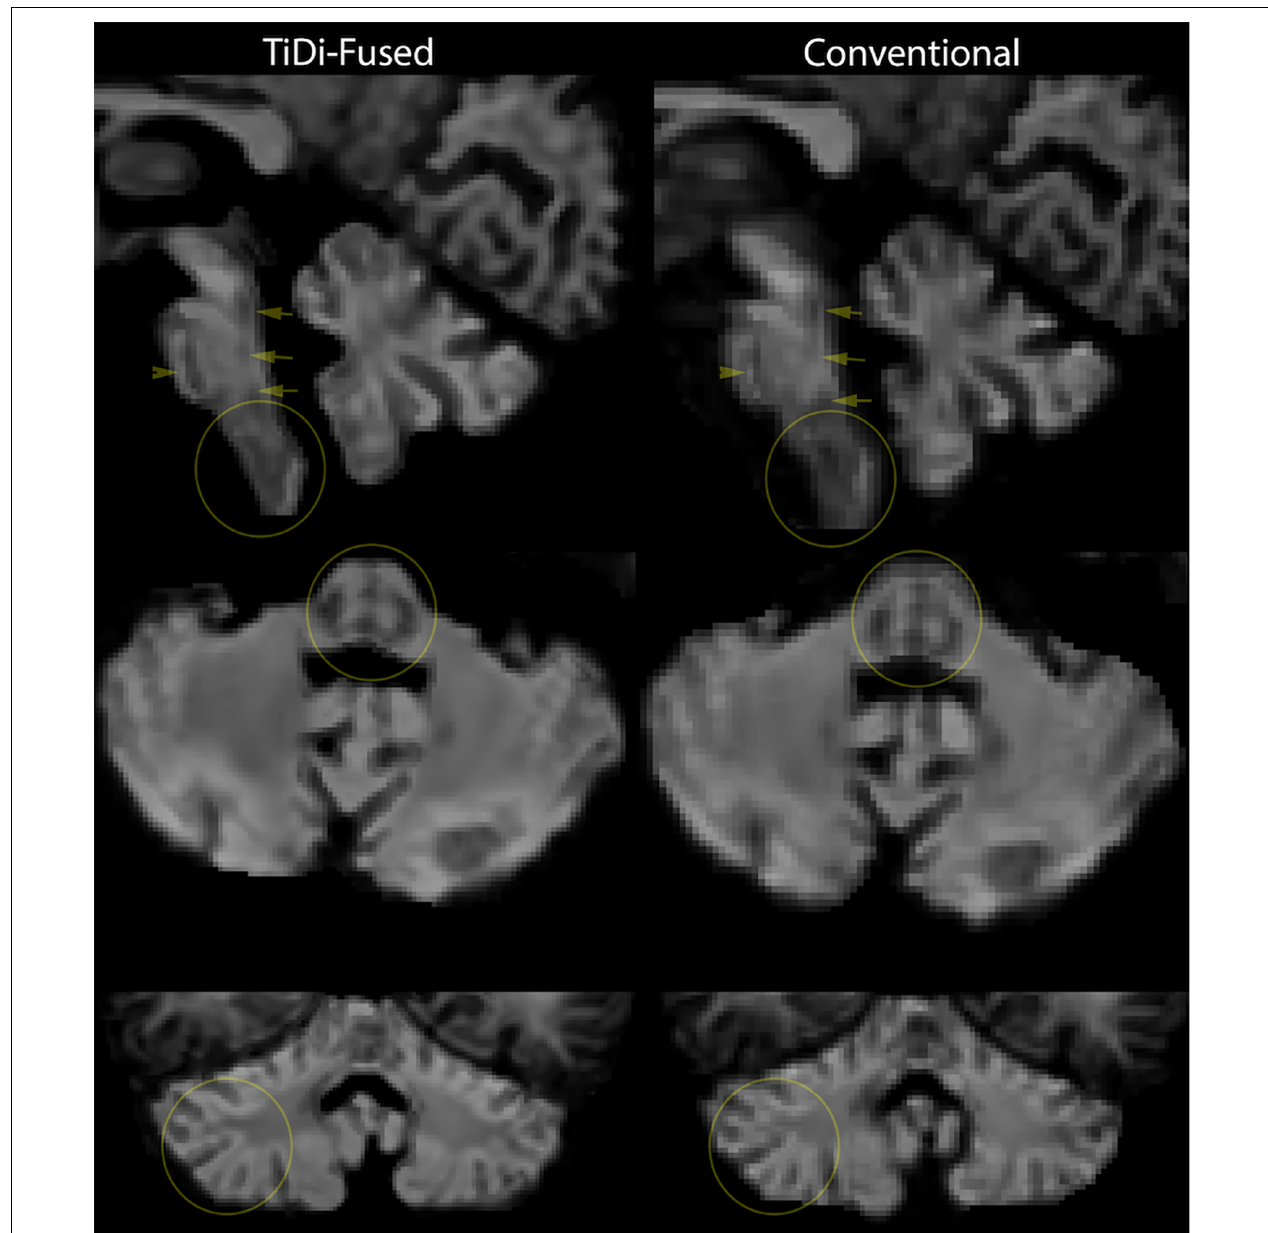
FIGURE 3 | Single-subject-level improvement (non-autistic 7-year-old) in gray-white matter contrast seen in apparent fiber density (AFD) in the brainstem and cerebellum. We chose the first scan of the study to demonstrate this, but this effect was representative of the dataset.